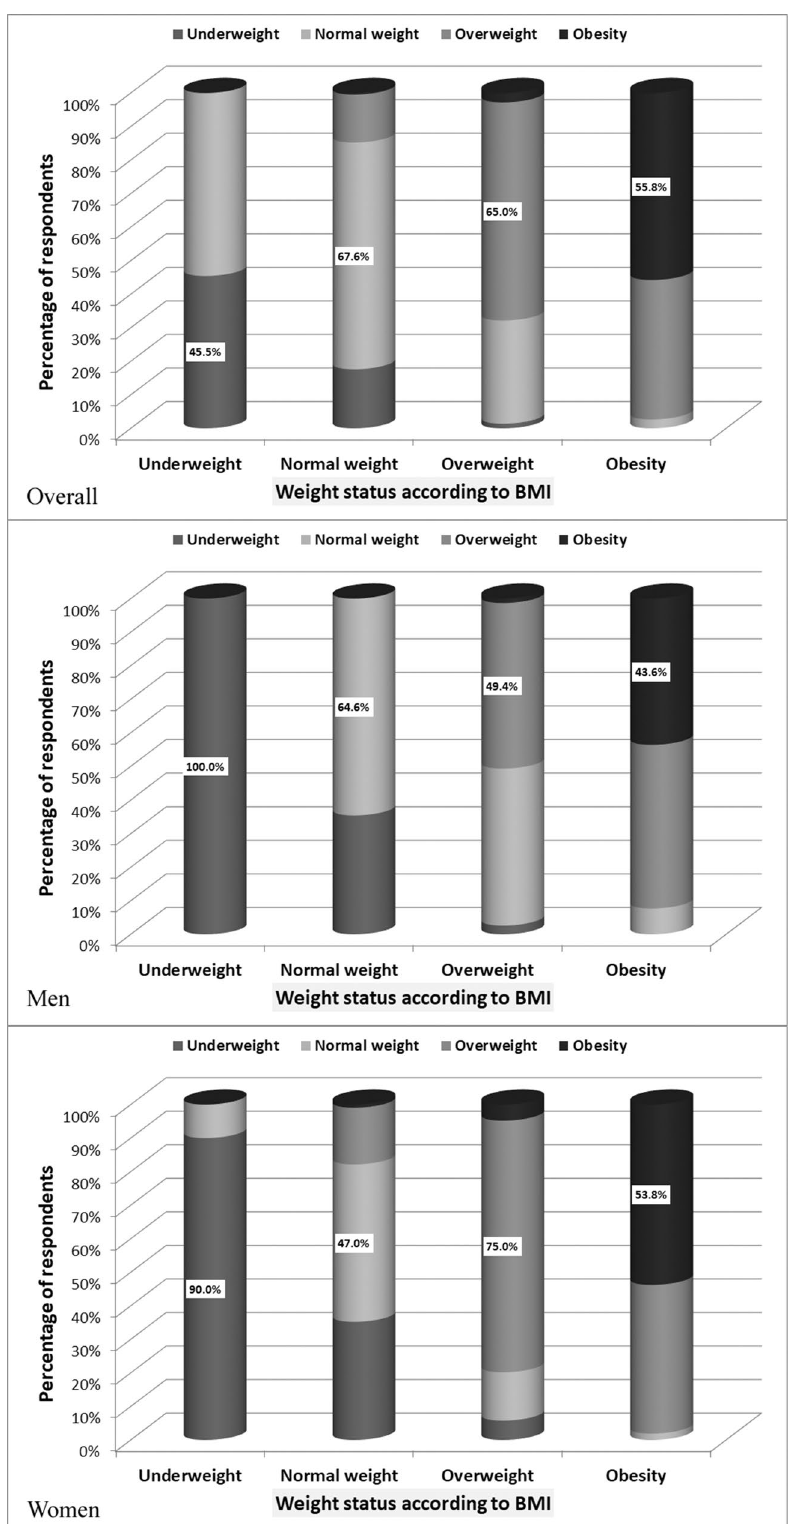
Figure 1. Comparison of compliance between subjective assessment of weight status according to the question (Do you think you are: underweight/normal weight/overweight/obese?) and weight status based on the